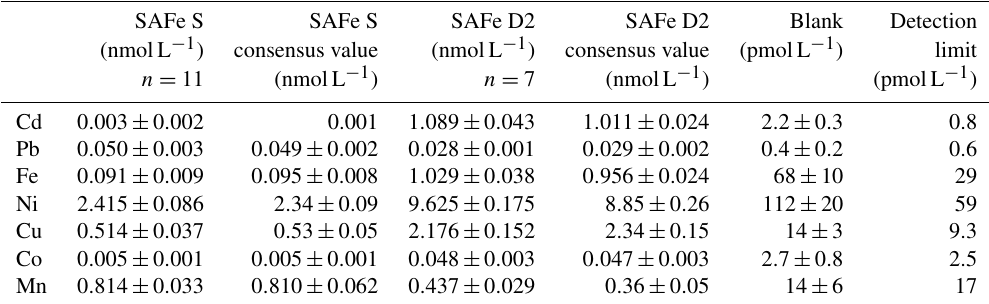
Table 1. Analyzed reference seawater, procedural blanks, and detection limits (3 times the standard deviation of the blank). Mean values and standard deviations for Cd, Pb, Fe, Ni, Cu, Mn, and Co as well as available consensus values ( ± 1 standard deviation); n represents number of measurements. SAFe S SAFe S SAFe D2 SAFe D2 Blank Detection (nmolL − 1 ) consensus value (nmolL − 1 ) consensus value (pmolL − 1 ) limit n = 11 (nmolL − 1 ) n = 7 (nmolL − 1 ) (pmolL − 1 ) Cd 0 . 003 ± 0 . 002